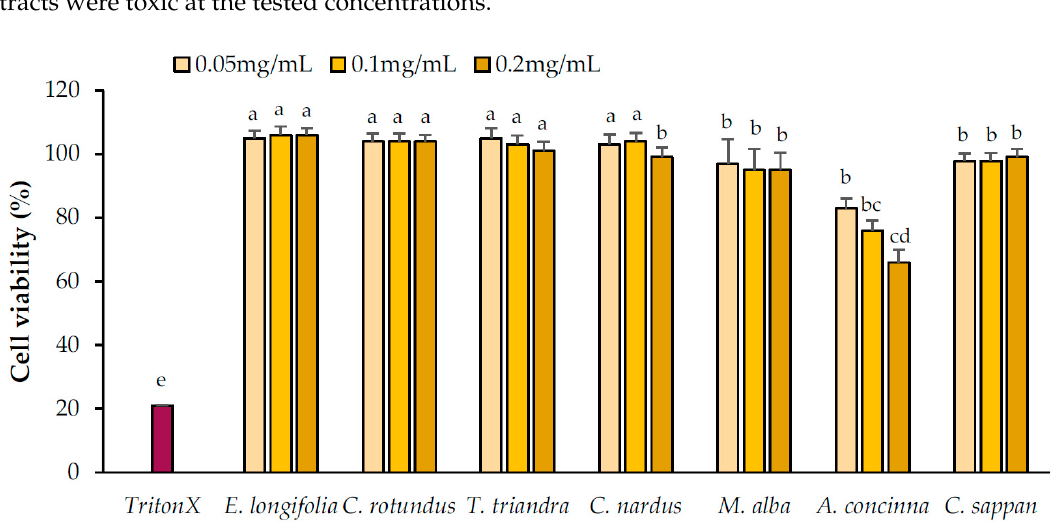
Table 2. Summary of the anti-obesogenic potential of the candidate plants.